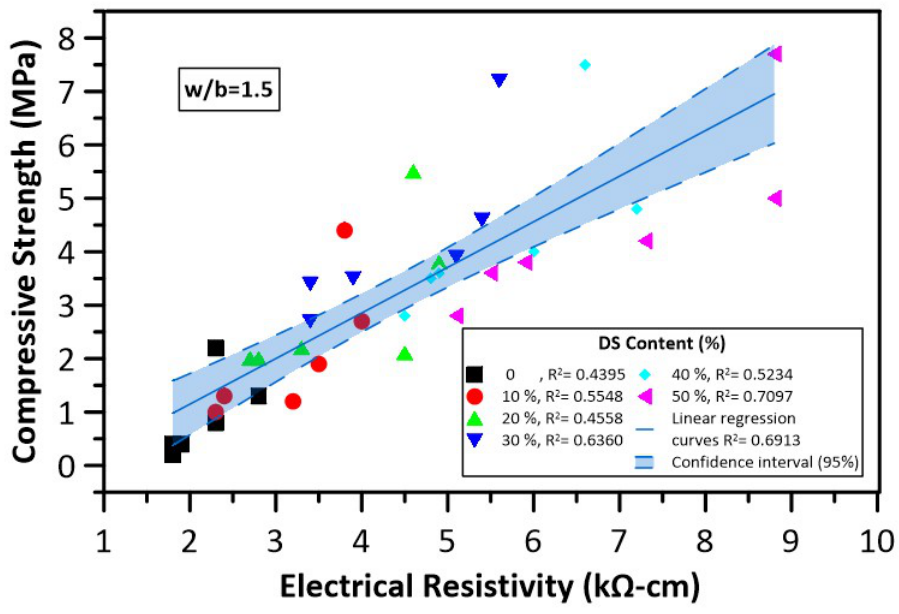
Figure 7. Linear regression relationship between the surface resistivity and compressive strength with various DS ratios of the CLSM.